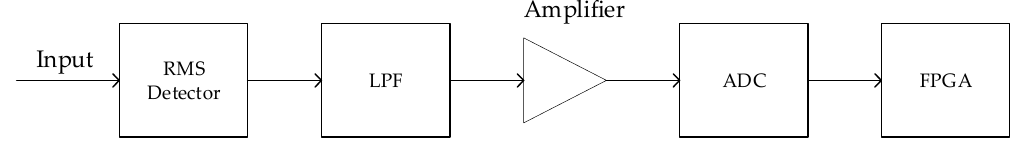
Figure 11. Schematic for power detection .